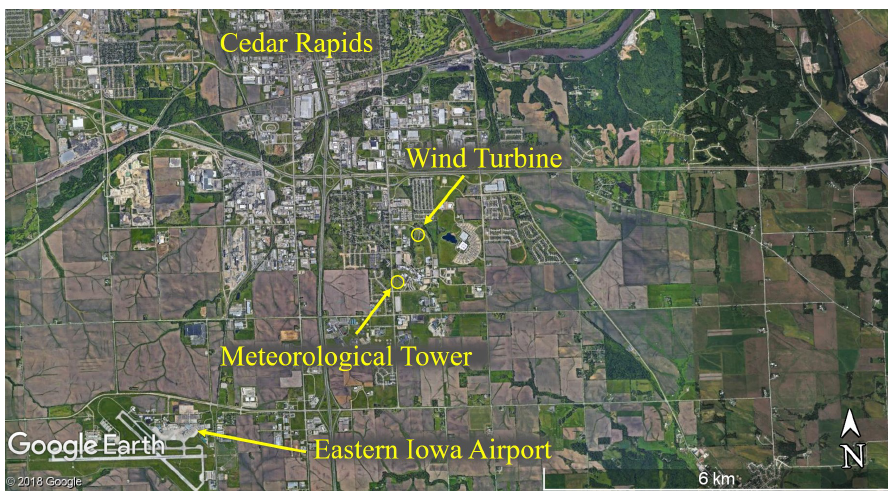
Figure 6. Satellite image of the location of the 106 m tall met tower and the stand-alone wind turbine in relation to each other and the City of Cedar Rapids. Image: Google.